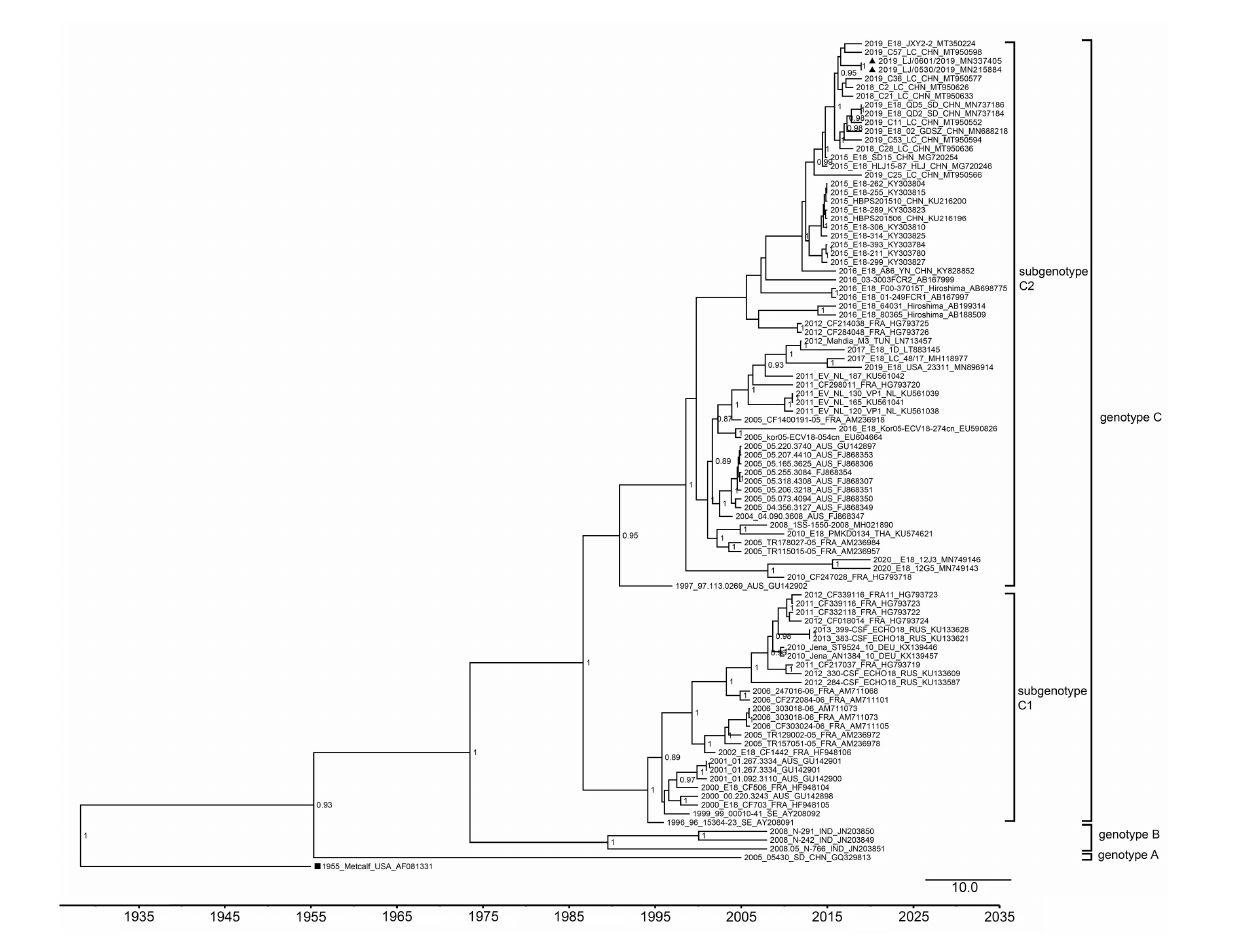
FIGURE2 Phylogenetic tree based on the VP1 gene of echovirus 18. The phylogenetic tree was constructed using BEAST software. The posterior probabilities from the MrBayes analyses supporting the trees are indicated at the nodes. The triangle indicates the two strains in our study. The scale bar indicates years. The strain name, year of sampling, and GenBank accession numbers are